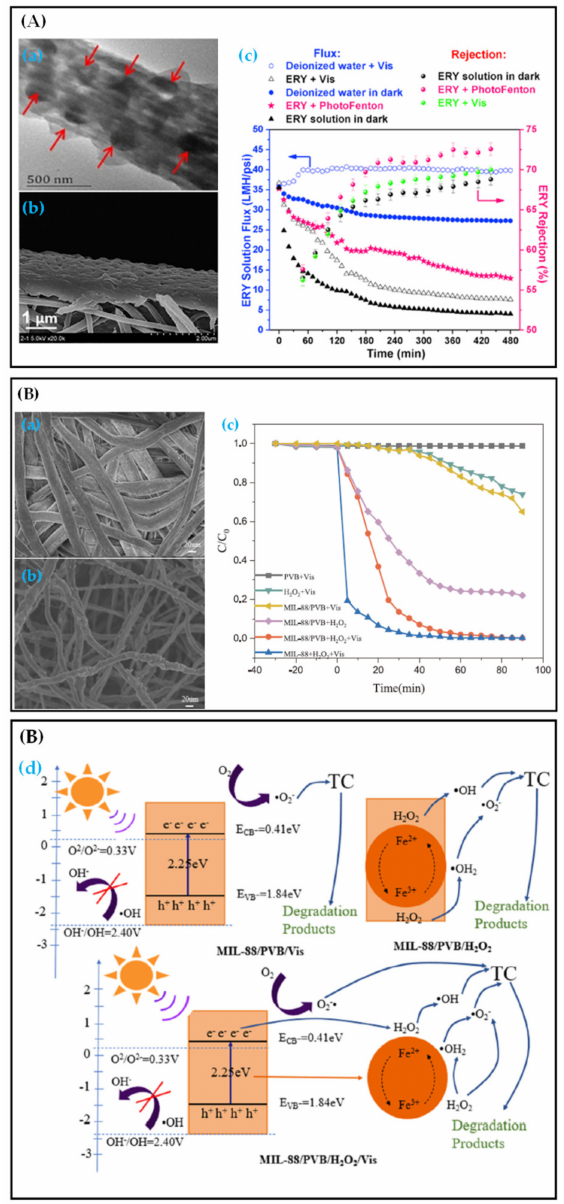
Figure 11. ( A ) CS/PAN@FeOOH/g-C 3 N 4 photo-Fenton membrane [181]: ( a ) SEM image of single PAN@FeOOH/g-C 3 N 4 nano-support fiber, ( b ) SEM image of cross-sectional structure and ( c ) water flux and rejection of ERY by the CS/PAN@FeOOH/g-C 3 N 4 membrane; ( B ) MIL-88/PVB photo- Fenton membrane [183]: ( a ) SEM image of PVB fibers, ( b ) SEM image of MIL-88/PVB fibers, ( c ) degradation activity of TC in different conditions and ( d ) the mechanism schematic diagram of the reaction